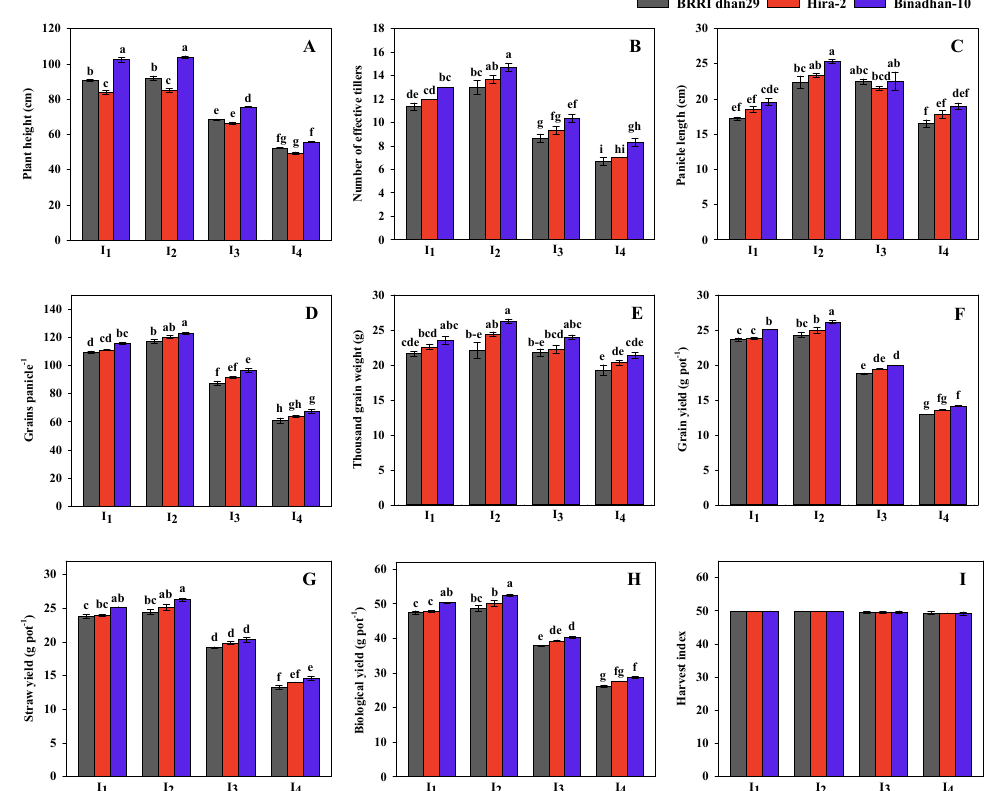
Figure 4. Yield and yield attributing traits of three rice cultivar under four irrigation regimes. I 1 - Continuous flooding, I 2 -Saturation, I 3 -75% of saturation, I 4 -50% of saturation. Figure 5 illustrates the correlation matrix of root parameters, development indices, yields, and yield parameters to investigate the relationship among them. GY showed a strong positive association with all root attributes. Yield contributing components such as ET, Pl, GP, TGW also had a positive and significant correlation with RN, RV, RL and RP. Again, root attributes and GY showed substantial and positive association with TDM and LAI.